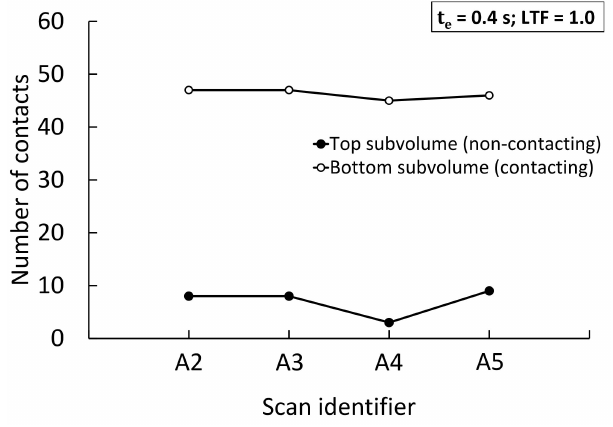
Figure 6. Number of contacts measured on scans acquired using different angular ranges and sample position, as presented in Table 1.